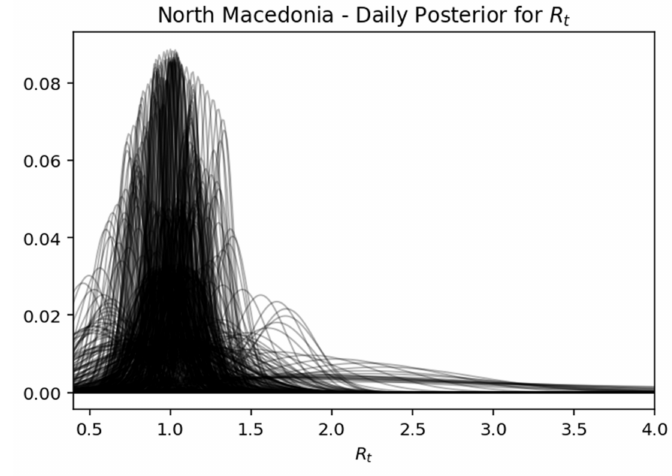
Figure 21. North Macedonia—daily posterior for R t .